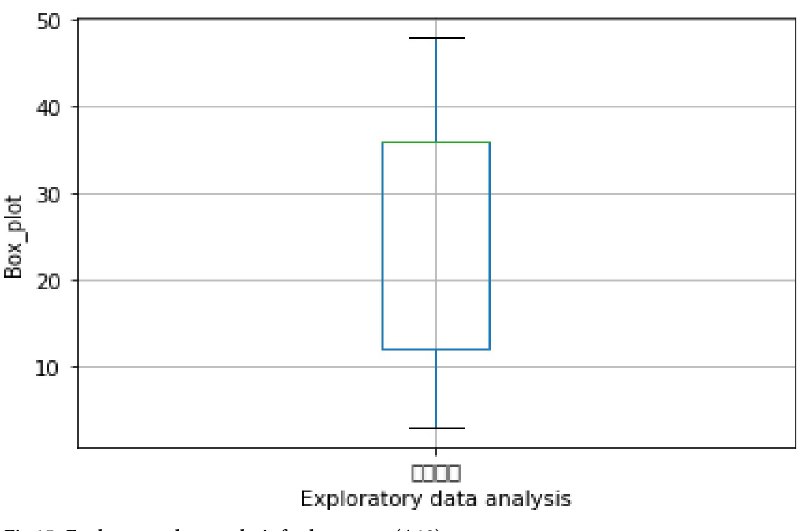
Fig 15. Exploratory data analysis for loan term